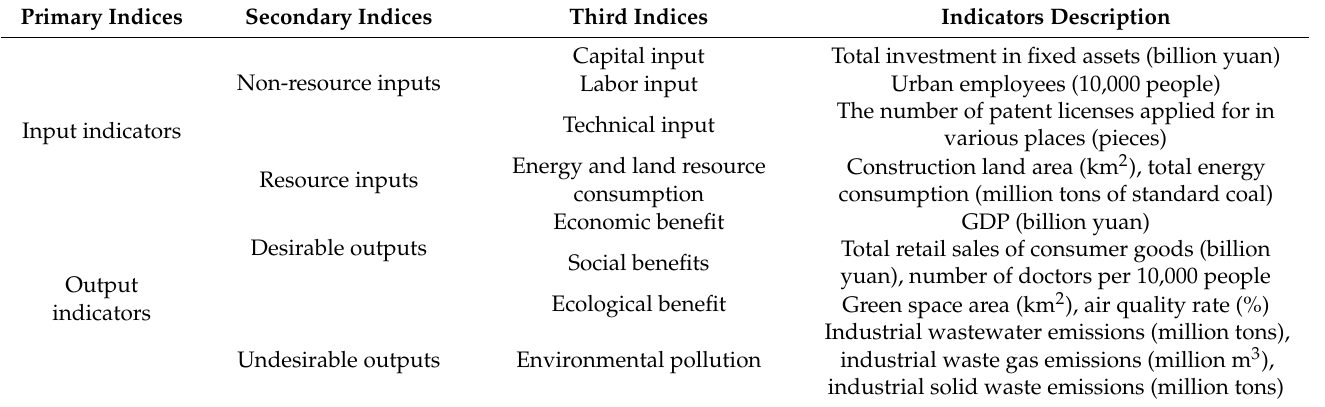
Table 1. Green development efficiency measurement index system.